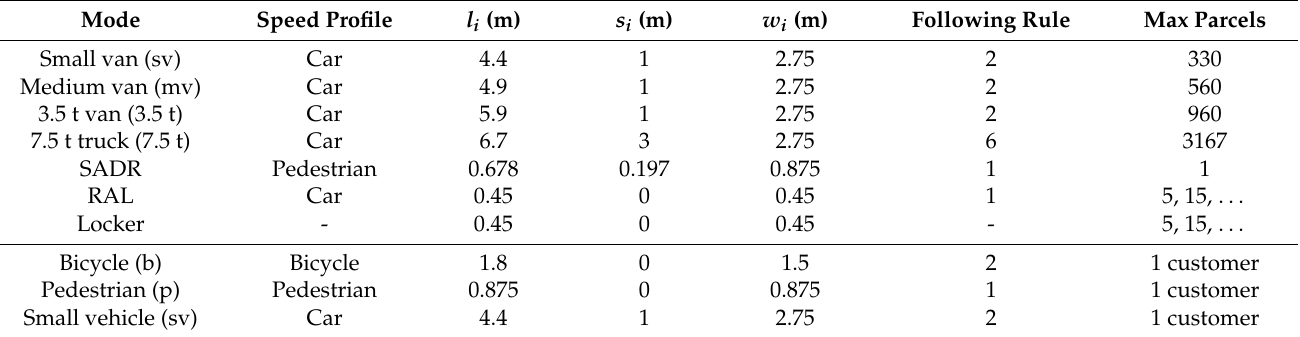
Table 1. Simulation specifications (source: adapted from